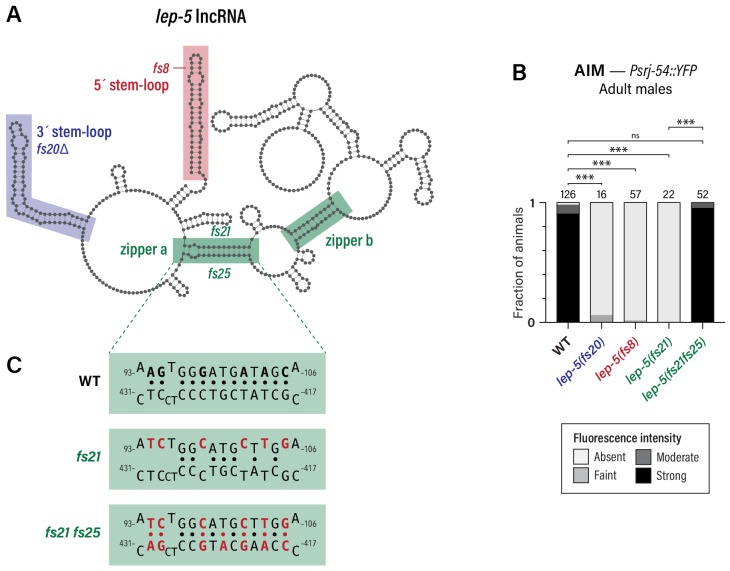
Structural features of the lep-5 lncRNA required for its function in the nervous system.(A) A predicted model for lep-5 secondary structure; see Kiontke et al., 2019 for details. Colored shading indicates regions disrupted by the mutants tested. (B) Expression of Psrj-54::YFP in adult males of the indicated genotype. Numbers above each bar indicate numbers of animals scored. (C) The fs21 allele mutates six nucleotides (shown in red) important for the predicted zipper ‘a’ region. The fs21 fs25 allele mutates an additional seven positions ~ 325 nt in the 3´ direction in a manner predicted to allow zipper ‘a’ to re-form, even in the presence of significant changes in its primary sequence (Kiontke et al., 2019).10.7554/eLife.43660.007Figure 2—figure supplement 1—source data 1.Source data for Figure 2—figure supplement 1.